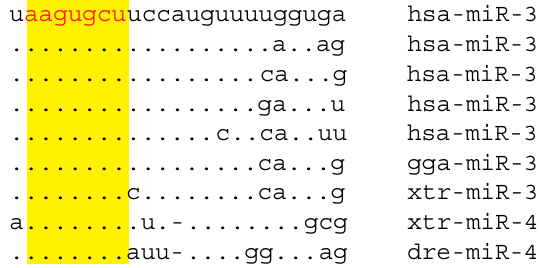
Figure 1. miRNAs with an AAGUGC seed. Human ( Homo sapiens ) hsa-miR-302a, b, c, d map to an intron of the LARP7 gene and are processed from the 3p arm of their pre-miRNAs. The highly similar “hsa-miR-302e” maps to a different location and is processed from the 5p arm of its pre-miRNA. This is an example of evolutionary convergence in sequence. gga-miR-302c-3p from chicken ( Gallus gallus ) and xtr-miR-302-3p toad ( Xenopus tropicalis ) also map to the intron of LARP7 and have a common evolutionary origin with hsa-miR-302a–d-3p. xtr-miR-427-3p from Xenopus tropicalis and dre-miR- 430a-3p of zebrafish ( Danio rerio ) possess the same seed sequence as the miR-302s but it is unclear whether miR-427-3p and miR-430-3p are paralogous to bona fide miR-302s-3p or whether this is another example of evolutionary convergence. The AAGUGCU seed indicated in red font and yellow background.